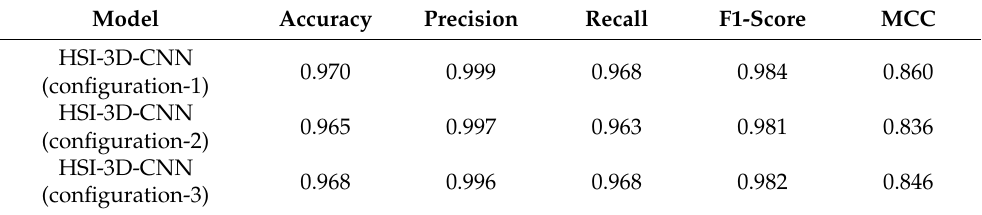
Table 13. Comparison of classification results of 3D-CNN when the training, validation, and testing sets are rotated between each other. (patch size parameter S = 100, 3D convolutions, see Figure A1 for network